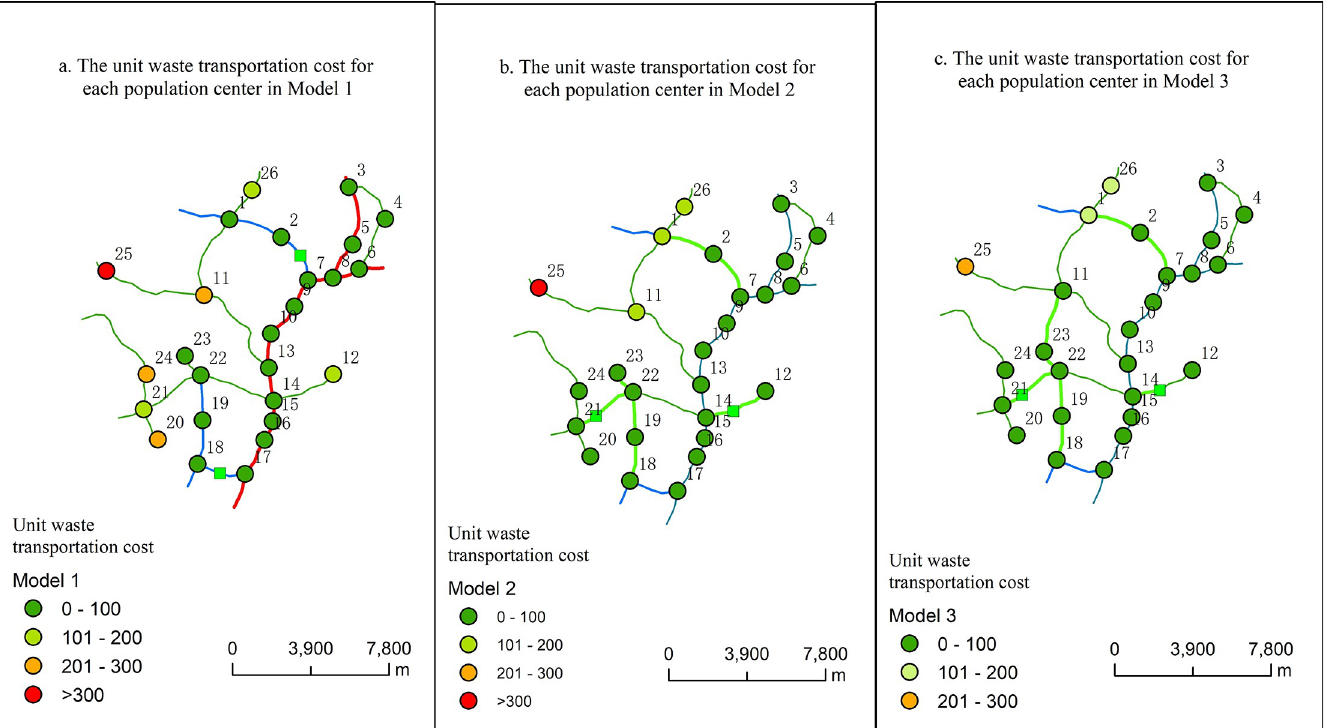
Fig 9. Spatial distribution of waste transportation costs in various settlements under various